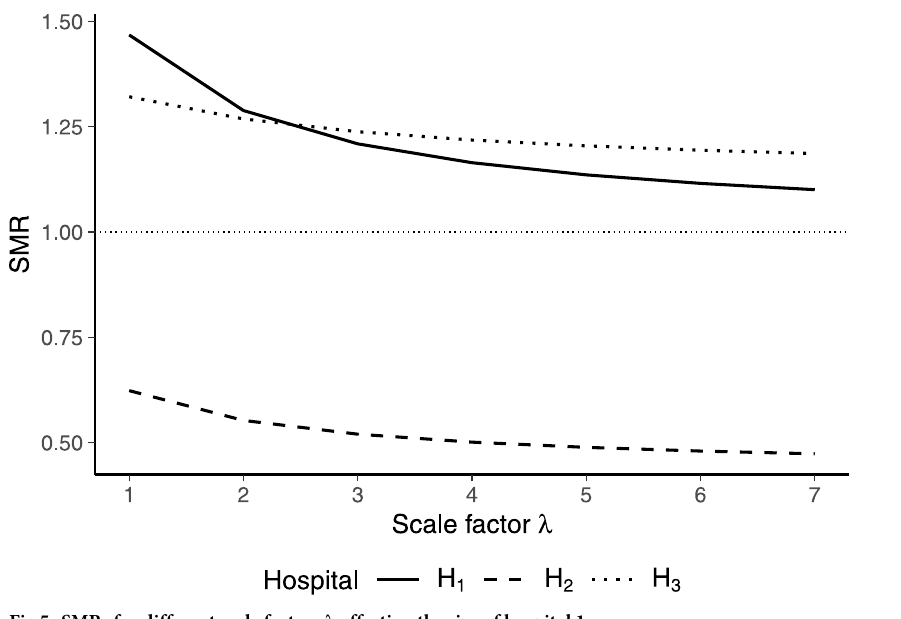
Fig 5. SMRs for different scale factors λ affecting the size of hospital